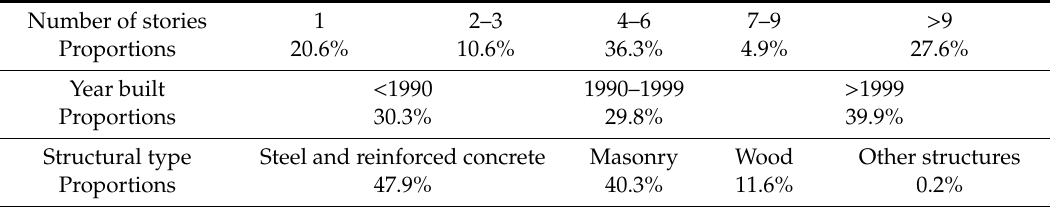
Table 1. Statistical data of the buildings for Haidian District, Beijing.